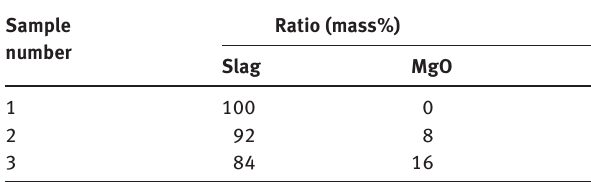
Table 2: The ratio of original slag to MgO (mass%)